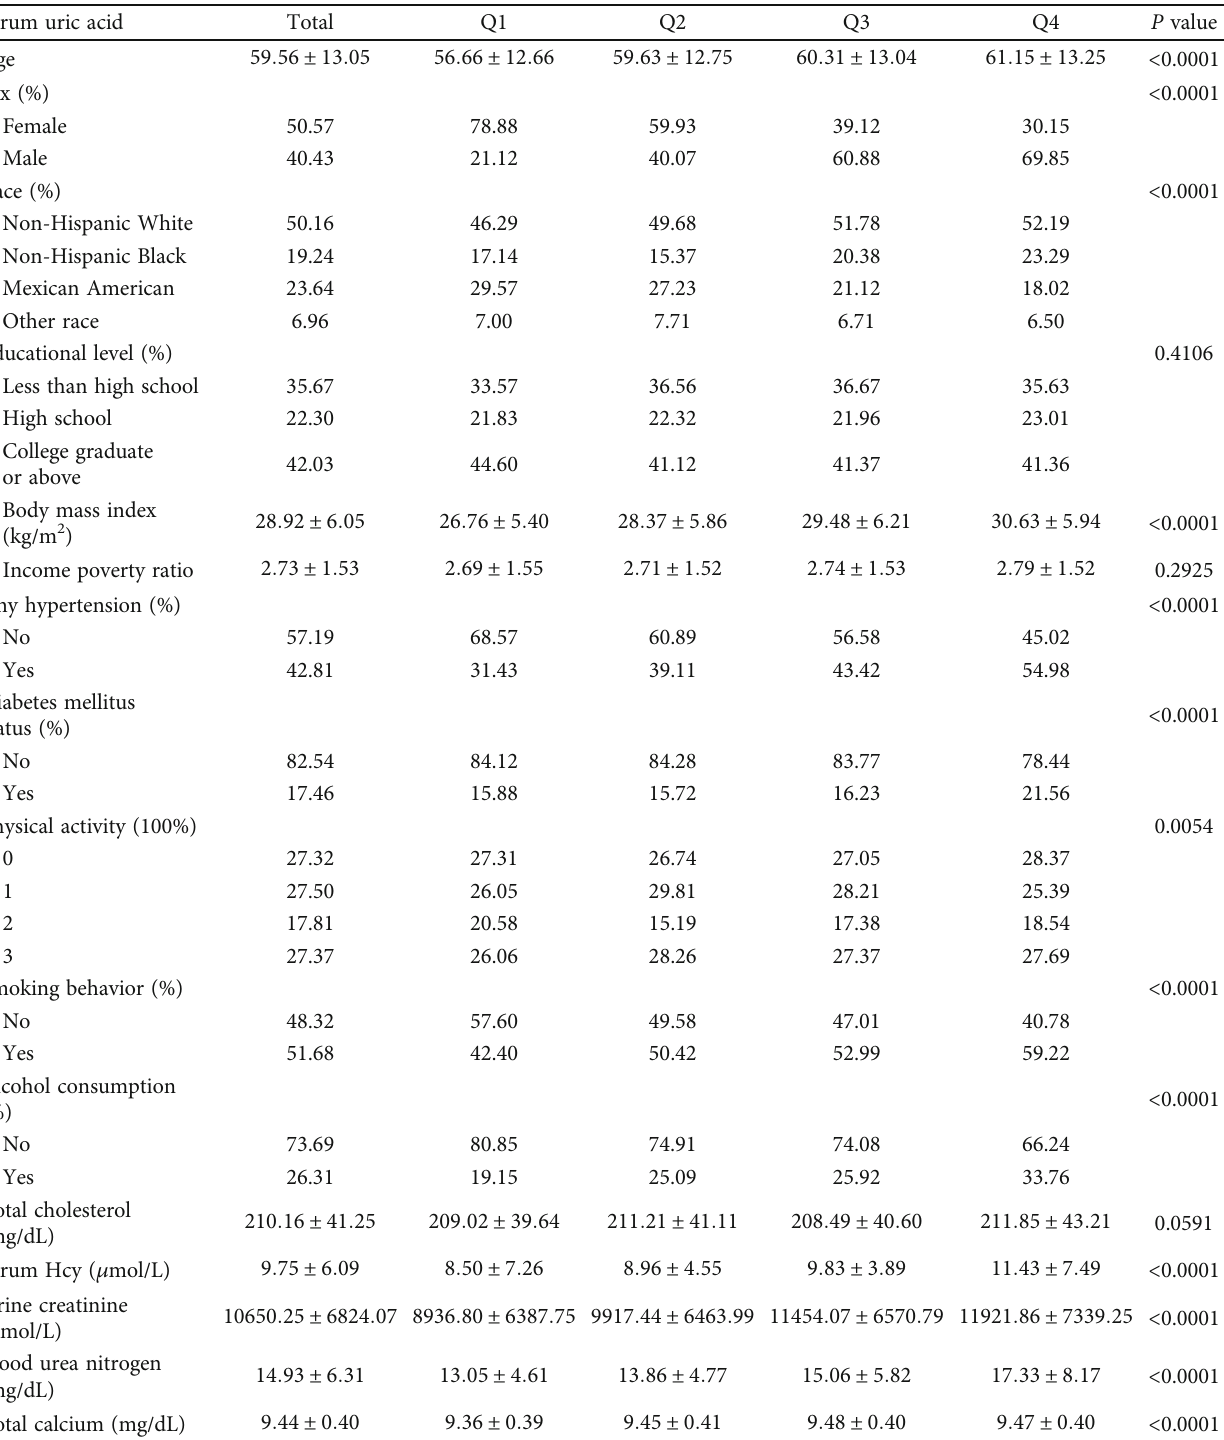
Table 1: Characteristics of